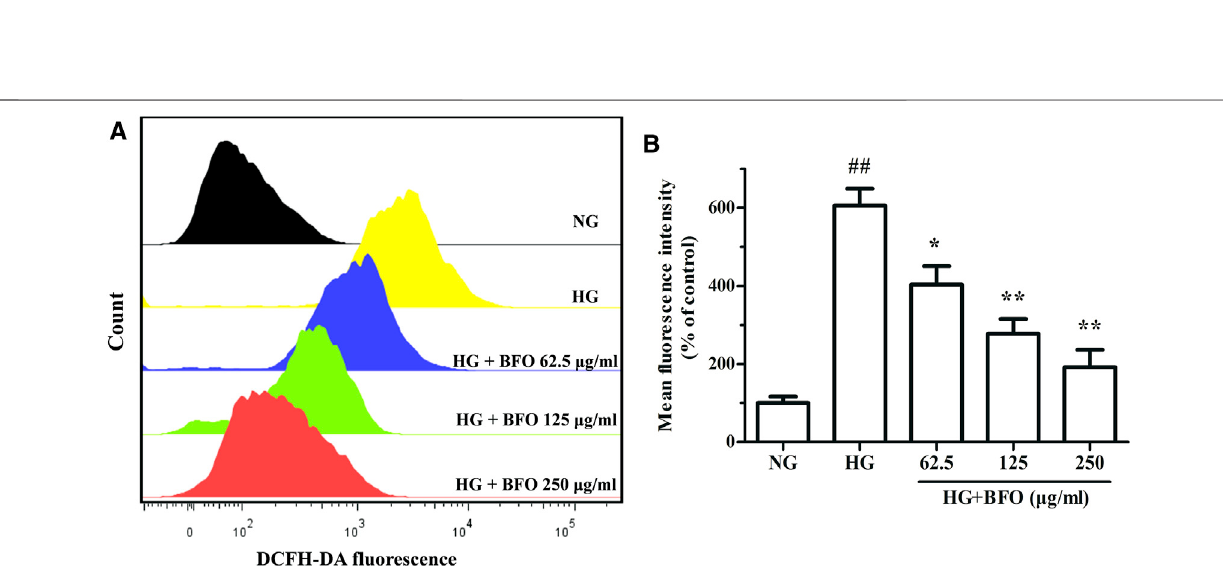
Frontiers in Pharmacology |